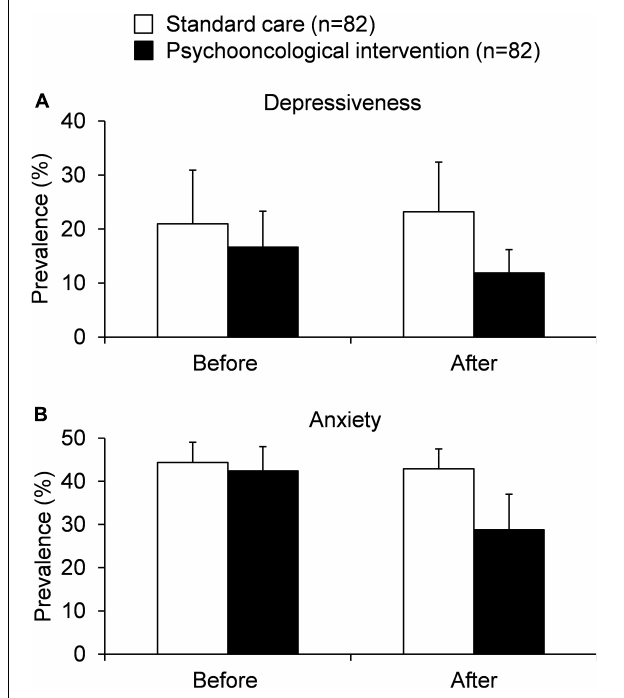
FIGURE 3 | Studies assessing the effect of psycho-oncological interventions in patients with hepatobiliary cancers on depressiveness (A) and anxiety (B) [based on Steel et al. (2007) and Wang et al.